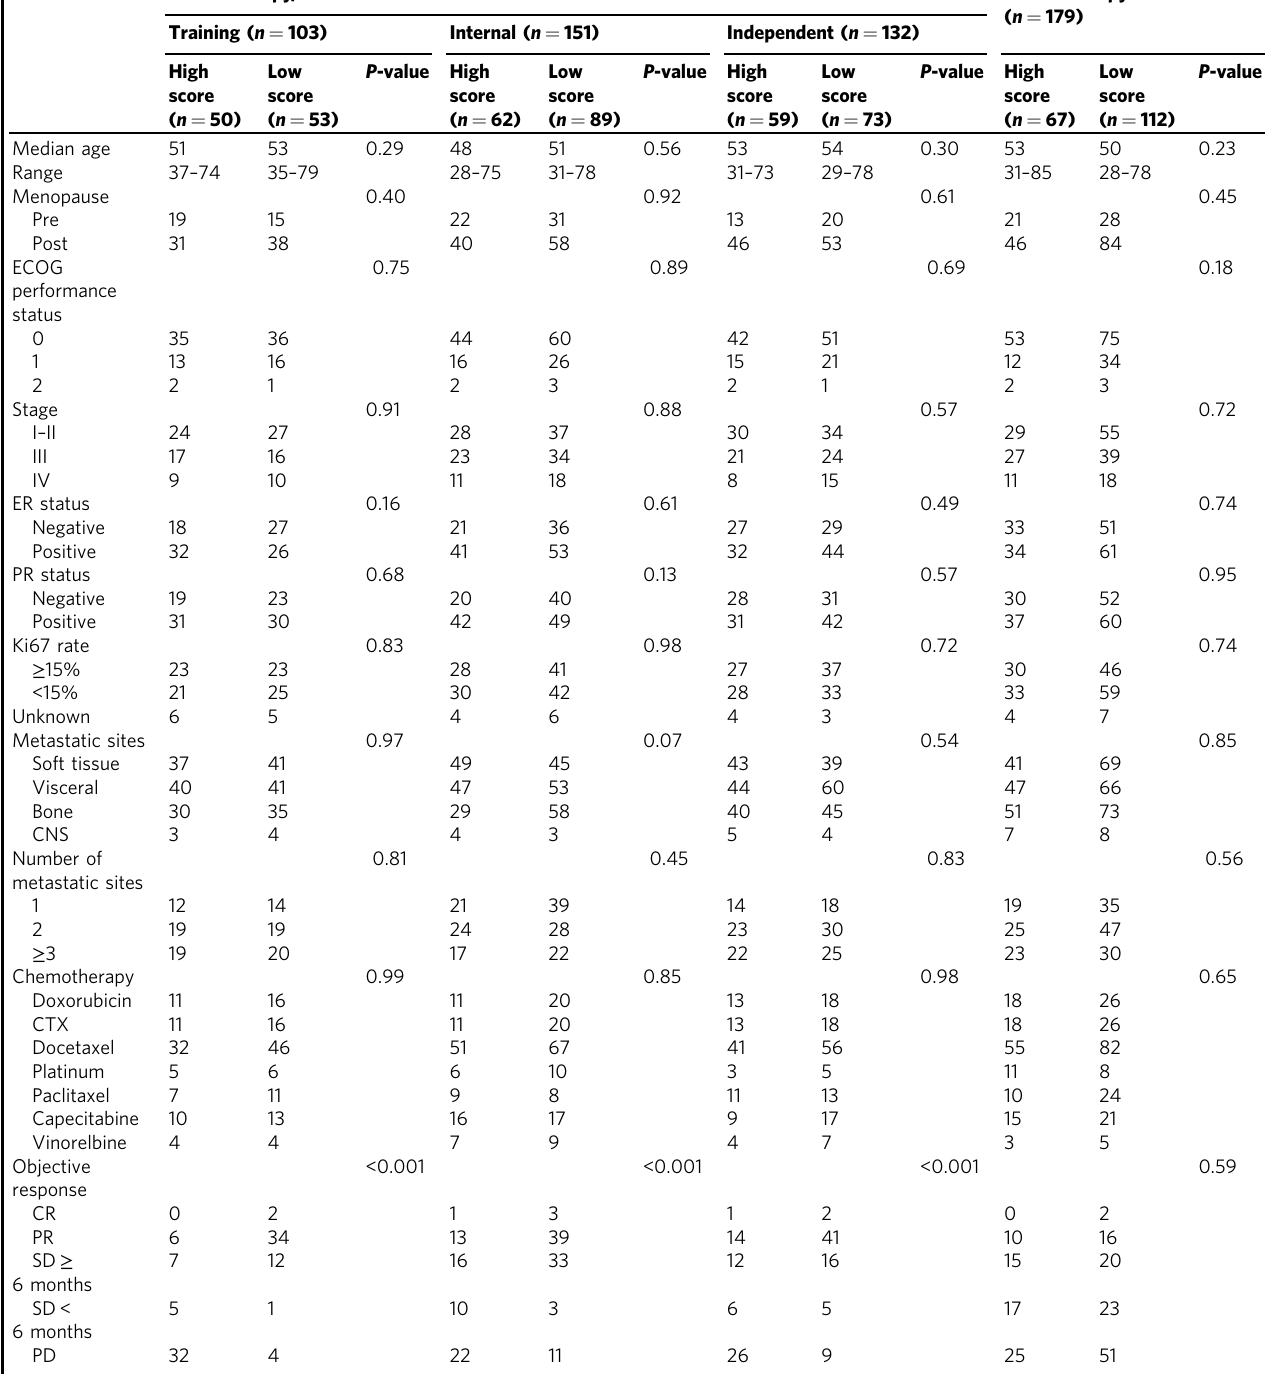
Table 1 Clinical characteristics of patients in the cohorts from 386 HER2 + MBC patients receiving fi rst-line chemotherapy with trastuzumab and 179 chemotherapy alone